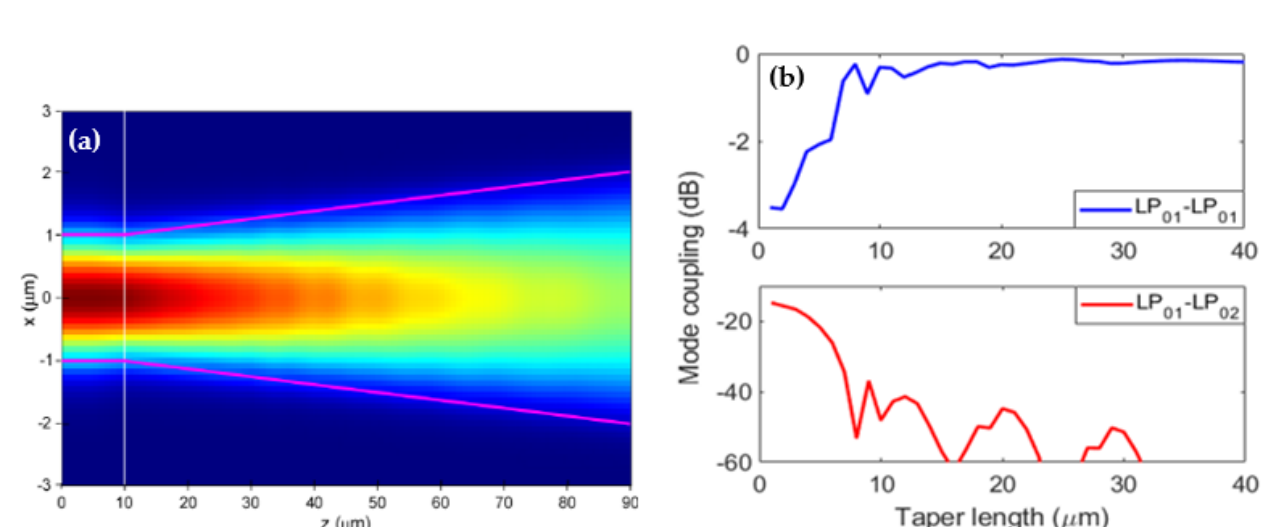
Figure 5. ( a ) Electric field propagation through the tapered waveguide, evolving from a 2 µ m to a 4 µ m diameter within ~80 µ m. ( b ) Output mode coupling efficiency to the fundamental LP 01 and higher-order LP 02 modes, as a function of taper length.